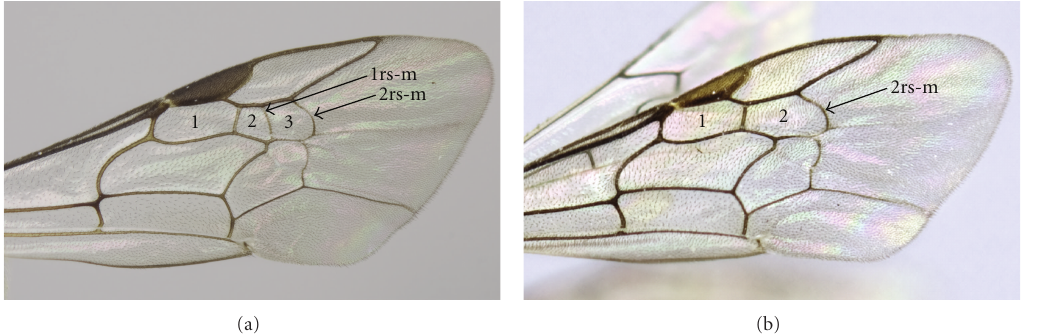
Figure 1: Forewing of Lasioglossum belonging to the Hemihalictus series. Numbers indicate submarginal cells. (a) Vein 1rs-m present. (b) Vein 1rs-m absent. Modified from [31].